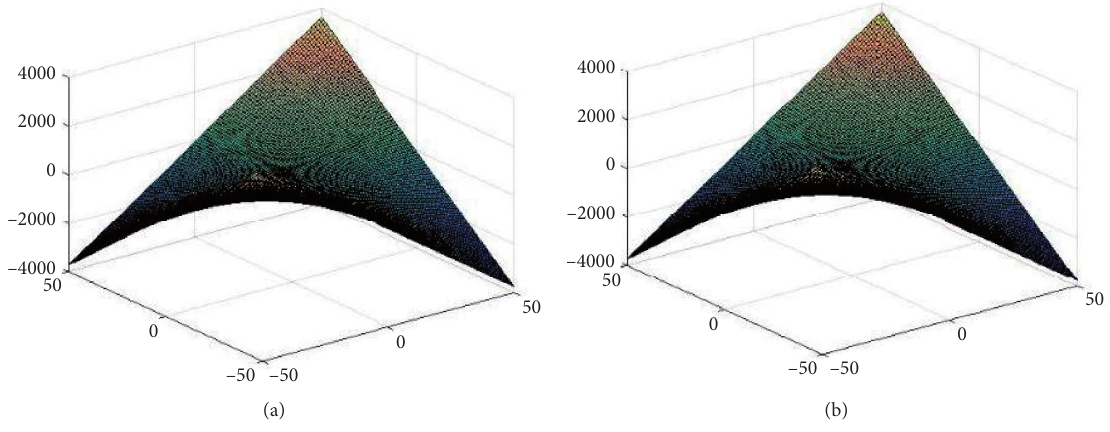
Figure 5: Modified the second Zagreb index plotted in 3D.